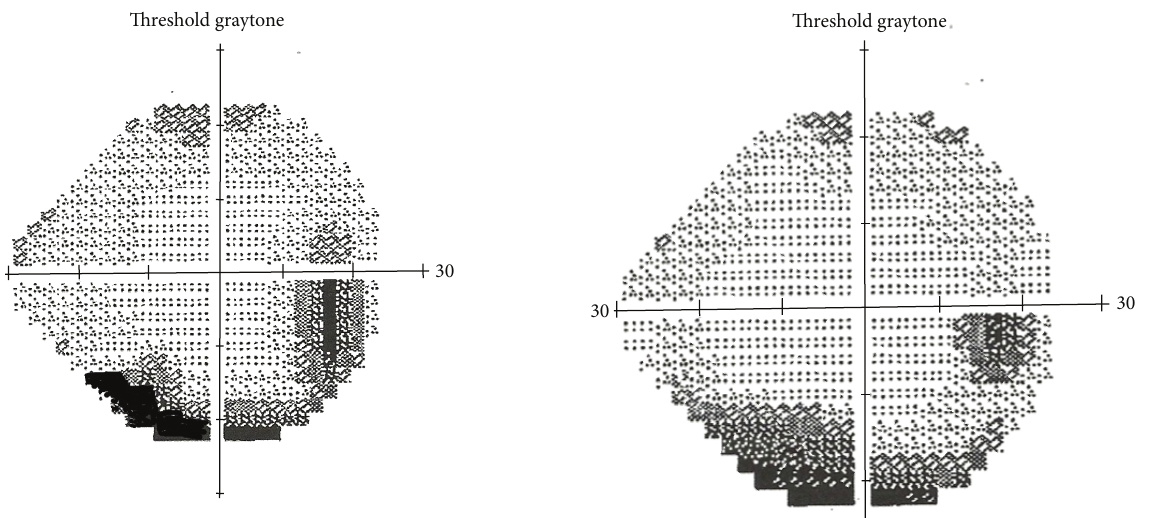
Figure 1: An automated perimetry visual field test before the treatment demonstrated arcuate scotoma, inferior partial arcuate defect, and superior vertical step defect that indicated optic nerve fiber bundle involvement.